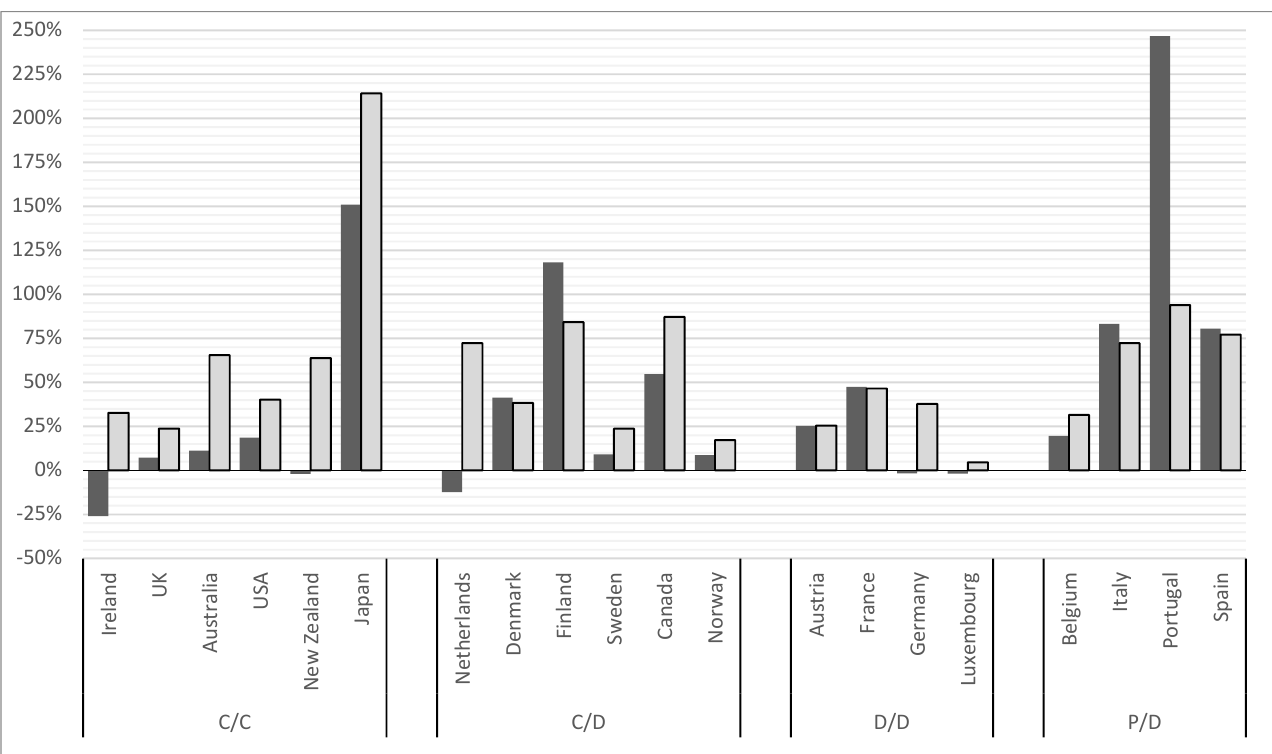
Figure 3. Change in Public Old-age Cash Benefits and 65+ Population, 1980–2017. Sources: (OECD 2021b; World Bank 2021).